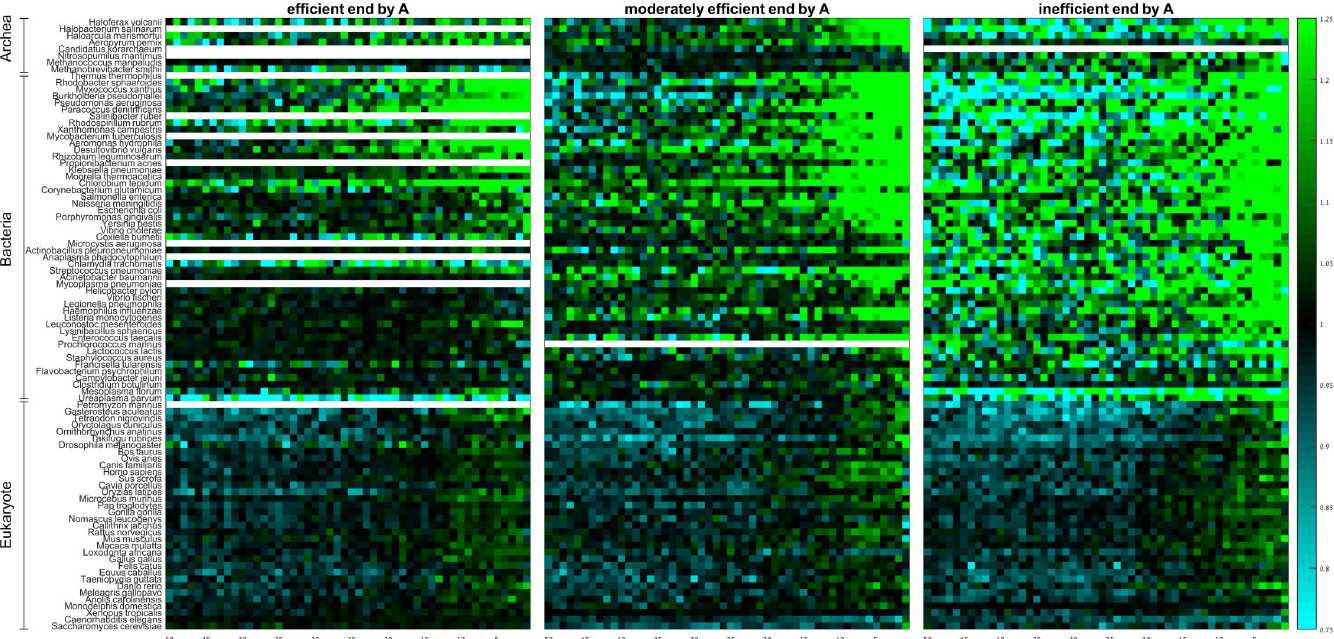
Fig 5. Group RSCA scores of efficient, moderately efficient, and inefficient codons that end by A along the last 50 codons of the gene. Rows denote species, columns denote positions. Species where none of the codons in a particular efficiency group end by A (missing data) are shown as white stripes. Species within domains are sorted from high (top) to low (bottom)